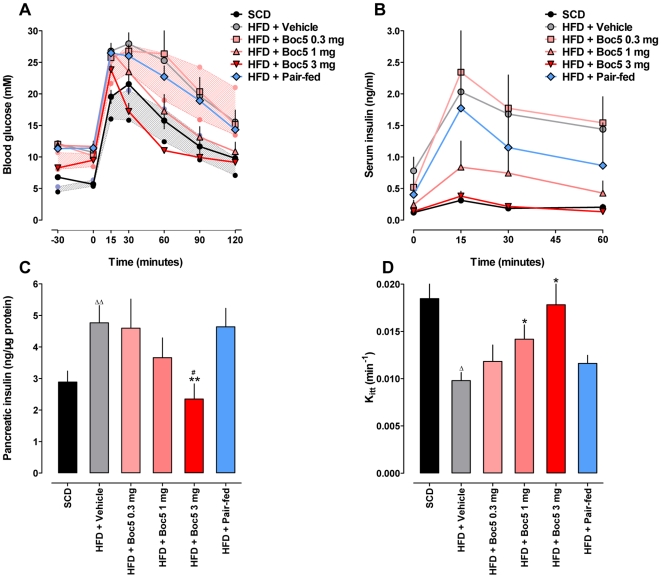
Effects of Boc5 on glucose homeostasis and insulin sensitivity.(A) Intraperitoneal glucose tolerance test (IPGTT) after 12 weeks of Boc5 treatment in diet-induced obese (DIO) mice (n = 6–8 per group). The pink and gray bands respectively denote mean±SD of blood glucose levels measured in obese (HFD) and lean (SCD) mice prior to treatment. The glucose area-under-curve integrated from 0–120 min (AUC120) was calculated for each mouse. (B) Serum insulin response to an intraperitoneal glucose challenge one day after the cessation of Boc5 therapy. The insulin area-under-curve integrated from 0–60 min (AUC60) was calculated for each mouse (n = 8 per group). (C) Pancreatic insulin content measured at the end of treatment (n = 6–9 per group). (D) Effect on Kitt, a measure of insulin-mediated glucose clearance, in each treatment group (n = 8 per group). Values represent mean±SEM. Δ
P<0.05 and ΔΔ
P<0.01 compared with SCD group; *
P<0.05 and **
P<0.01 compared with HFD group; #
P<0.05 compared with pair-fed group that received an equal amount of food as 3 mg Boc5-treated mice.